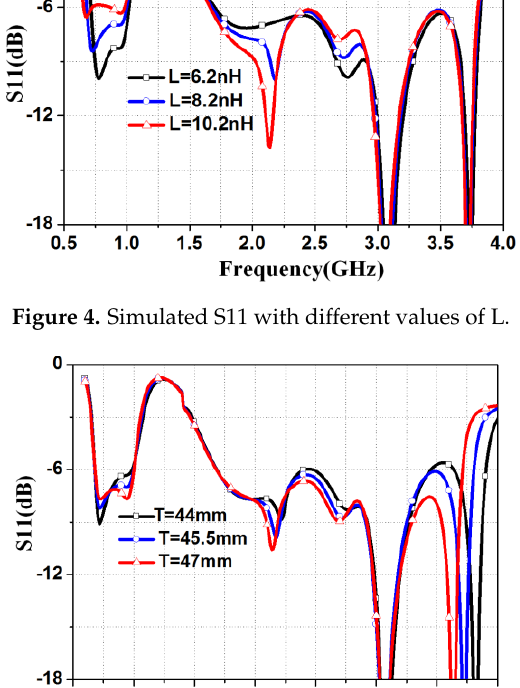
Figure 5. Simulated S-parameters with different values of T.